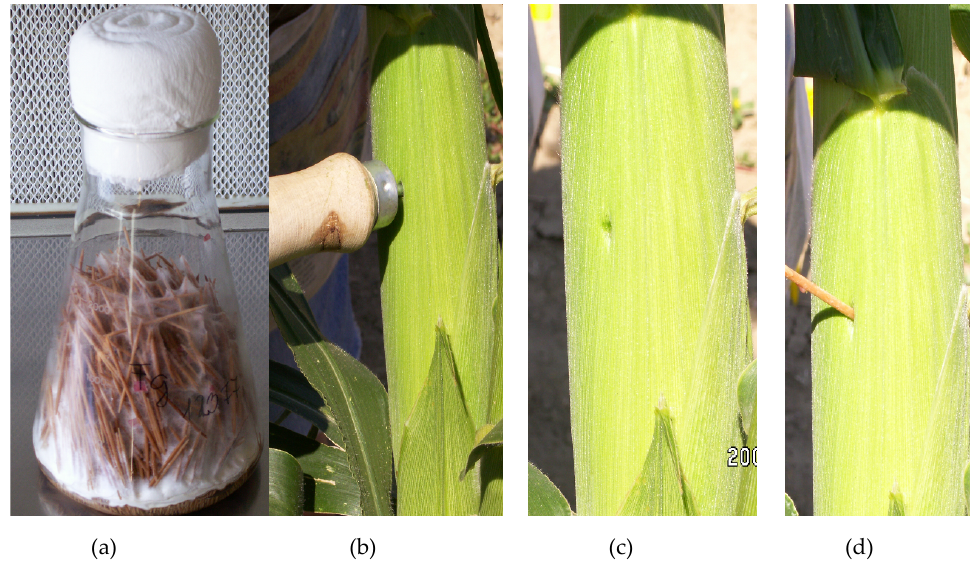
Figure 1. Toothpick inoculation by Fusarium spp. in maize cobs 6–7 days after midsilking. From left: ( a ) Fusarium infested toothpicks. ( b ) Making a hole by an awl, ( c ) . The hole on the ear, and ( d ) The toothpick inserted into the hole. Agronomy 2020 , 10 , x FOR PEER REVIEW